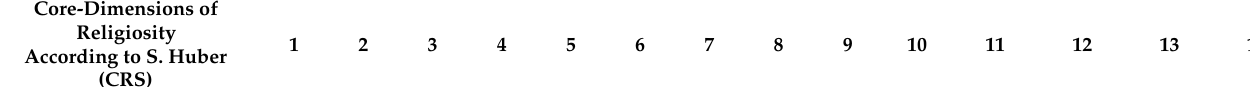
Table 5. The value of correlation (r) between the respondents’ religiosity and opinions on marriage, taking into account the variable of